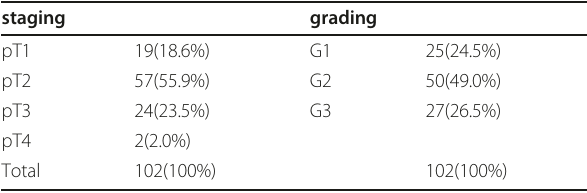
Table 1 Pathological staging and grading of 102 cases of invasive ductal carcinoma